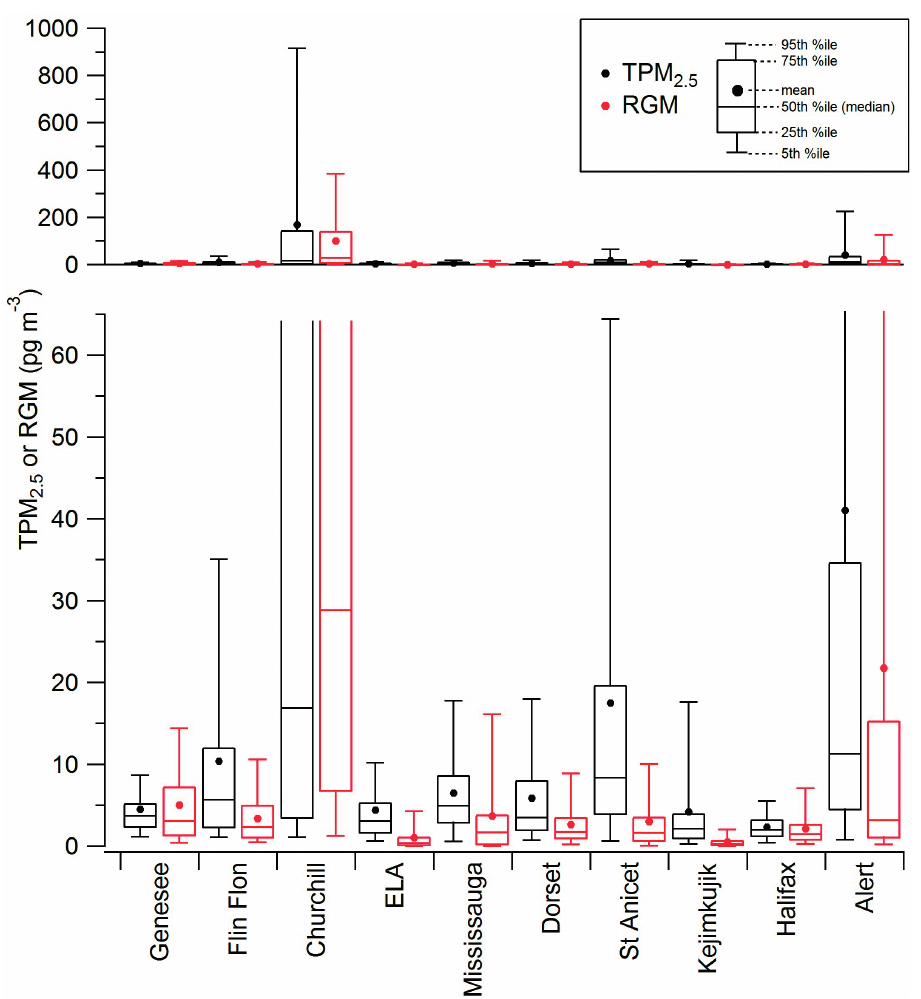
Figure 3. Comparison of reactive gaseous mercury (RGM) and total particulate mercury (TPM ) at mercury speciation stations. The top plot shows the full range to include Alert, 2.5 NU, and Churchill, MB. Time periods covered by measurements are listed in Table